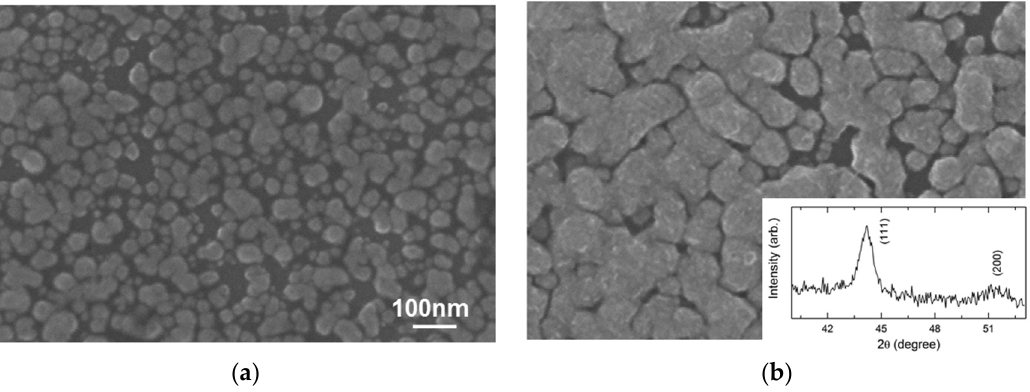
Figure 3. ( a ) Scanning electron micrograph of the sample under percolation obtained by an electrodeposition time of 5 s; ( b ) Scanning electron micrograph of the sample over percolation, obtained by an electrodeposition time of 15 s. The inset in ( b ) shows the results of XRD performed on the sample with a 100 s electrodeposition time, showing the preferential (111) and (200) orientation characteristic of permalloy material. The scale bar is the same for both images.